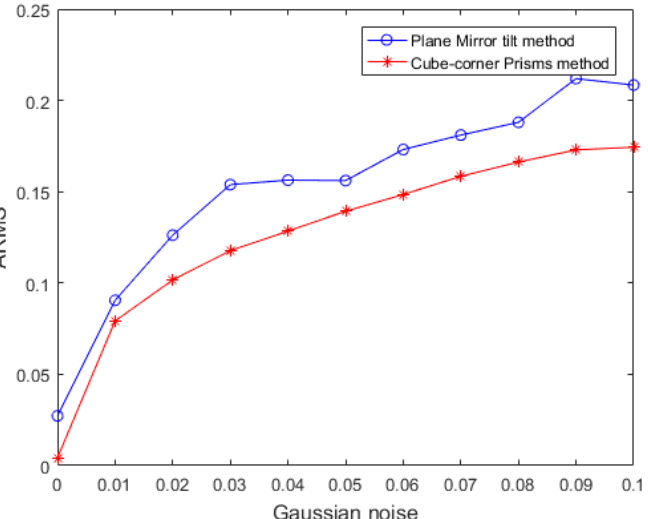
Figure 6. Absolute mean squared error curves for the results of the two methods after adding noise.